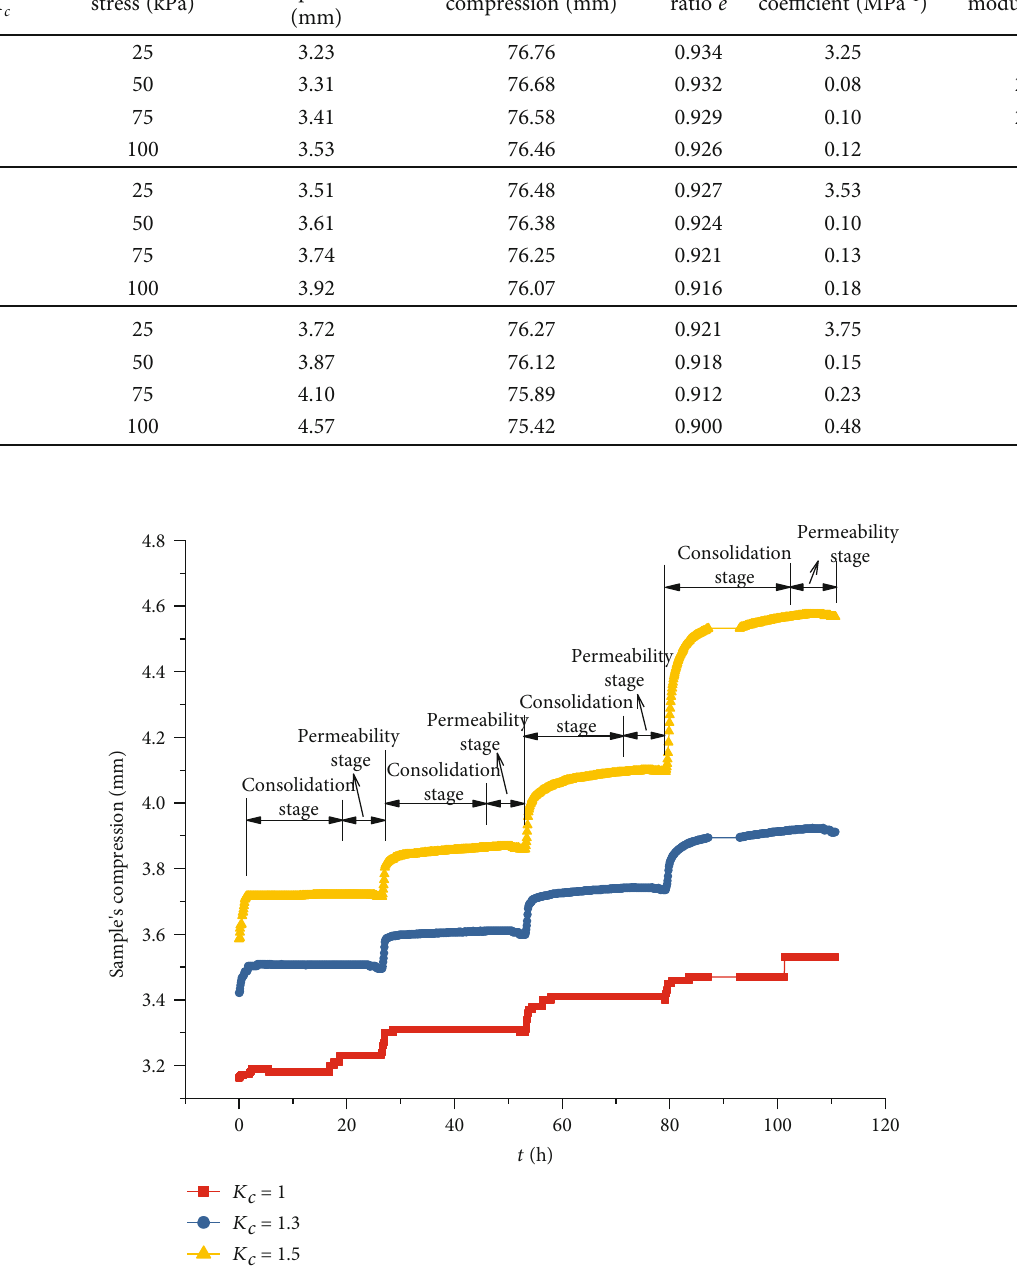
Figure 15: The curve of overconsolidation clay compression with time at di ff erent consolidation stress